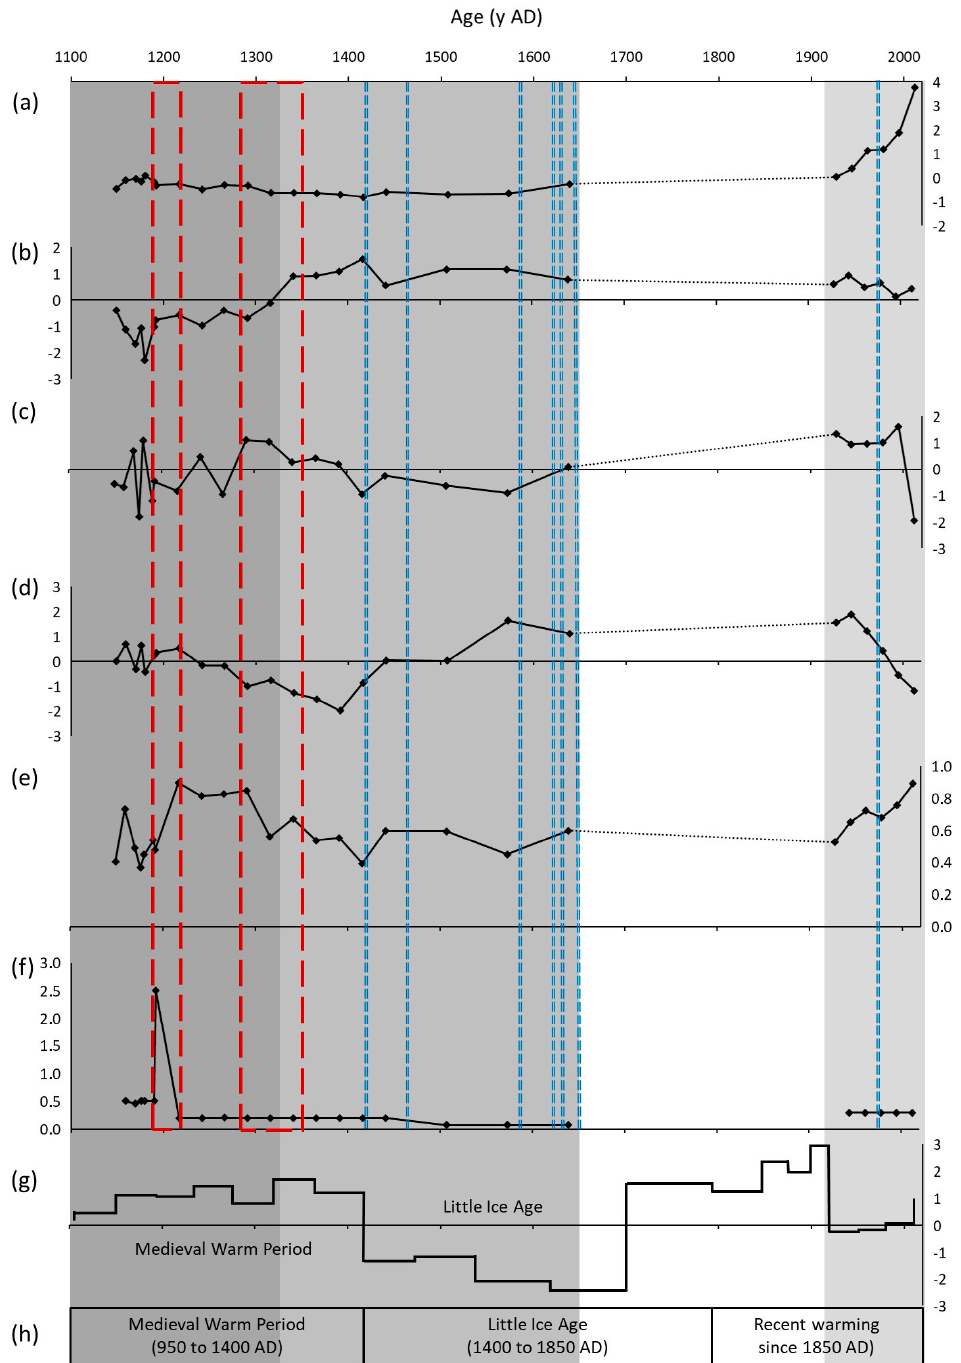
Figure 4. The factors of formation of the sedimentary record are depicted in relation to the chronological framework: ( a ) sample scores of PC1 GEO , showing the decomposition of soil organic matter; ( b ) sample scores of PC2 GEO, which represents intensity of land use; ( c ) sample scores of PC3 GEO, which are a proxy for the proportion of primary vs secondary minerals; ( d ) sample scores of PC4 GEO , showing the variations in sediment source; ( e ) sample loadings of PC2 MIN, representing the degree of pedogenesis; ( f ) sediment accumulation rates. The dominant climate conditions at the regional scale are shown in ( g ) temperature index from Mart í nez-Cortizas et al., (1999); and ( h ) climate periods from Desprat et al., (2003). The periods when the main reforms of the religious buildings were made are shown in m–dashed red rectangles, and the punctual minor maintenance interventions are in n–dashed blue lines (dates from Blanco-Rotea et al., 2015 and Sanjurjo-S á nchez et al., in press), as described in the text. The shades of grey indicate the sample clustering as calculated by the hierarchical cluster analysis (cluster 1, 2, and 3 depicted in dark, medium, and light